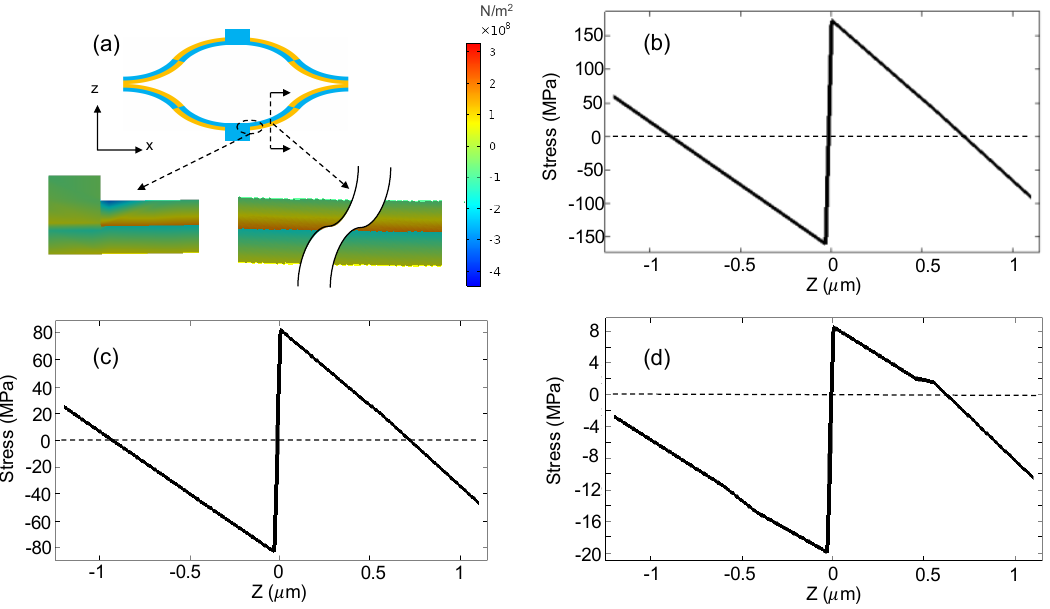
Figure 9. ( a ) Stress distribution on bimorph cross section at − 4.5 ◦ . ( b ) Stress as a function of z-position at − 4.5 ◦ . ( c ) Stress as a function of z-position at − 2.5 ◦ . ( d ) Stress as a function of z-position at − 0.5 ◦